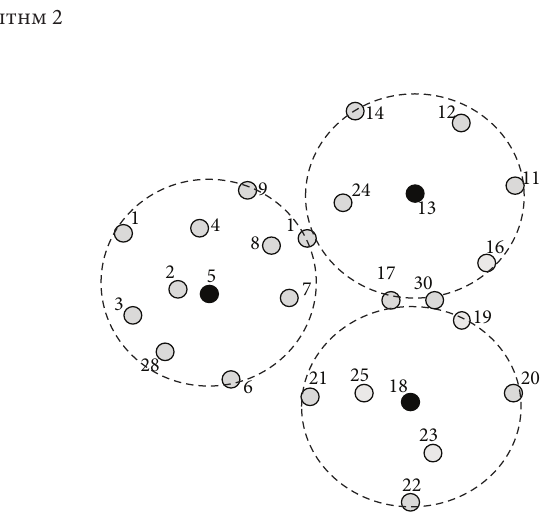
Figure 3: MANET after algorithm phase 1 with DS.